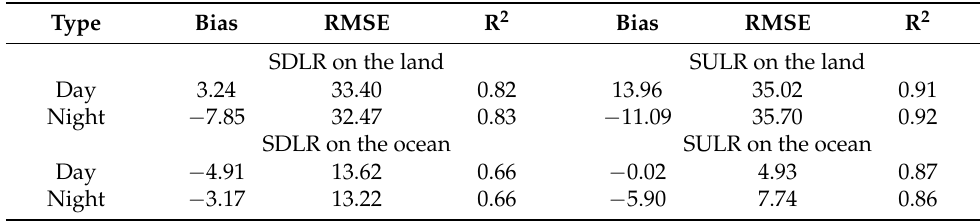
Table 4. The validation results of the surface longwave radiation components at land and ocean sites. The units of both bias and root mean square error (RMSE) are W/m 2 . SDLR: surface downward longwave radiation. SULR: surface upward longwave